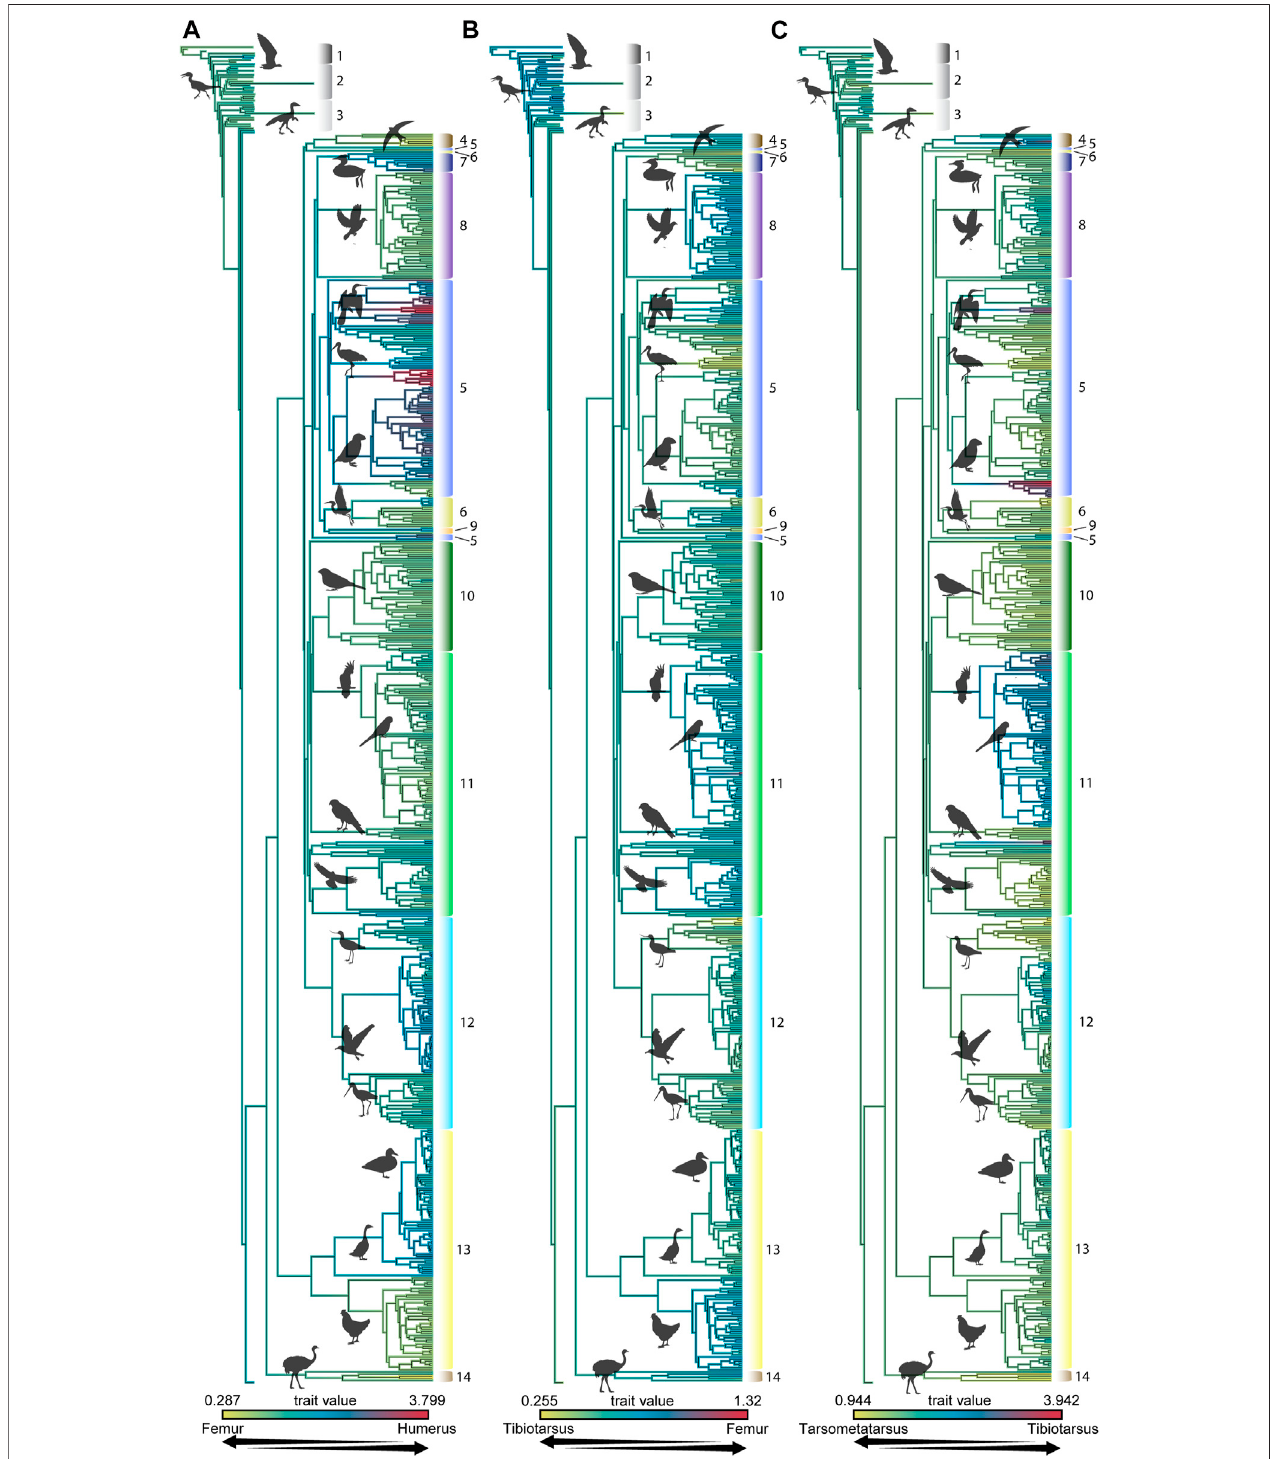
FIGURE3| Proportionsoftheuntransformedlengthsofthehumerustofemur (A) ,femurtotibiotarsus (B) ,andtibiotarsustotarsometatarsus (C) mappedontothe phylogeny created for this analysis. Phylogenetic grade numbers are as follows: 1 Non-ornithothoracine taxa, 2 Enantiornithes, 3 Ornithuromorpha, 4 Strisores, 5 Ardeae, 6 Gruiformes, 7 Mirandornithes, 8 Columbimorphae, 9 Otidimorphae, 10 Passeriformes, 11 Telluraves, 12 Charadriiformes, 13 Galloanserae, 14 Palaeognathae.